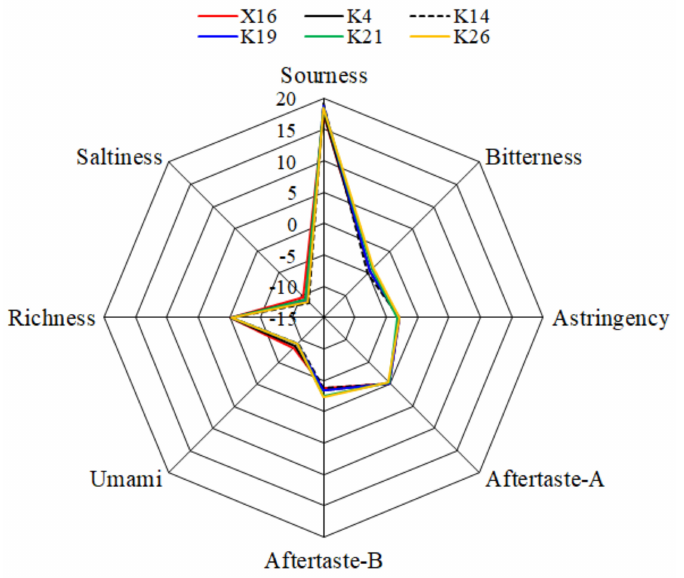
Figure 6. Electronic sensory characteristics of KFP wine fermented with different